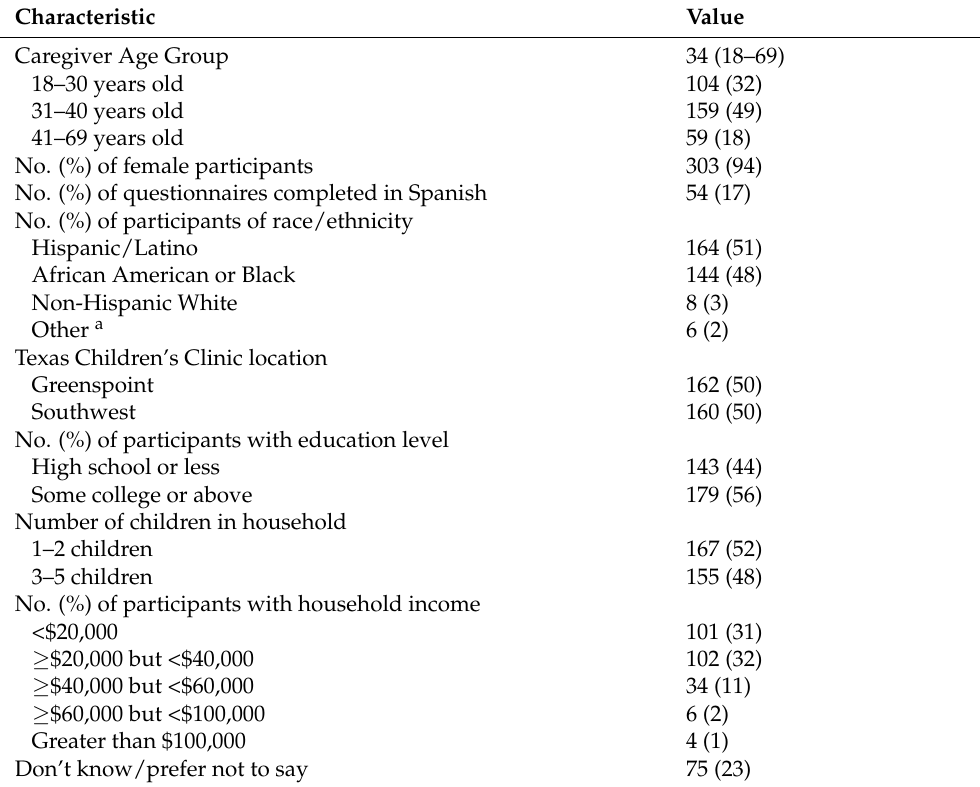
Table 1. Sociodemographic characteristics of participants ( n =